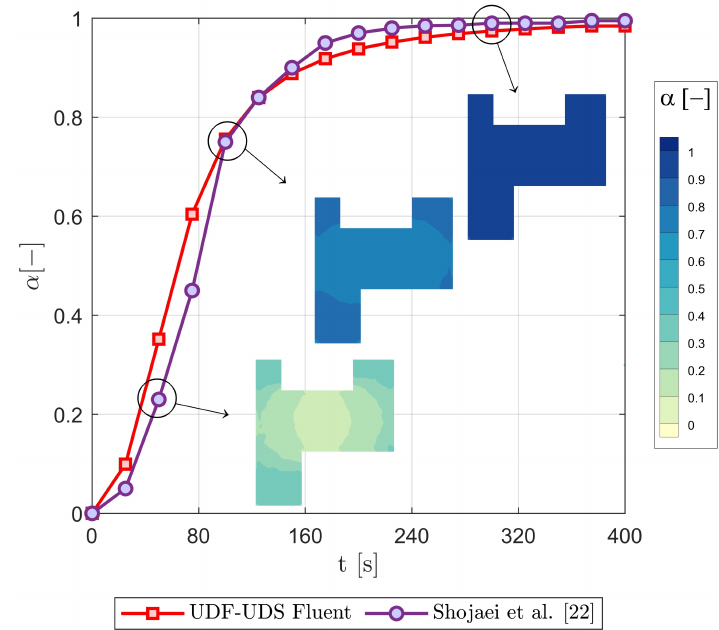
Figure 6. The degree of cure versus time at a mould temperature of 60 ◦ C.